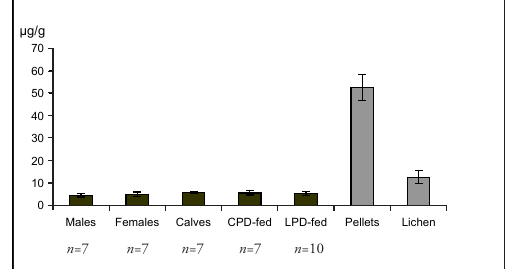
Fig. 3. Squalene content (% of NL and standard devia- tion) in meat from reindeer fed different types of pellets compared to free ranging animals of different age and sex. Abbreviations: CPD: con- ventional pellet diet; LPD: linseed pellet diet; NL: neutral lipid fraction.